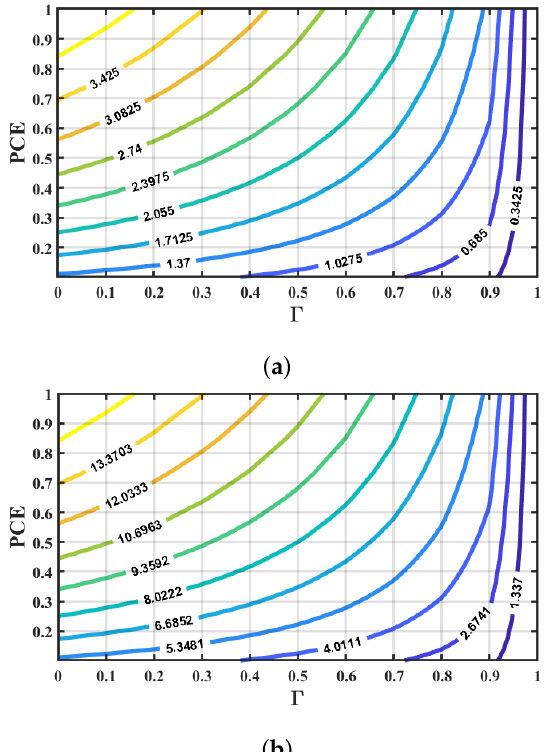
Figure 32. Proposed self-powered sensor read range. ( a ) Measured read range for 65.62 mW irradiated power. ( b ) Extrapolated read range for 1 W irradiated